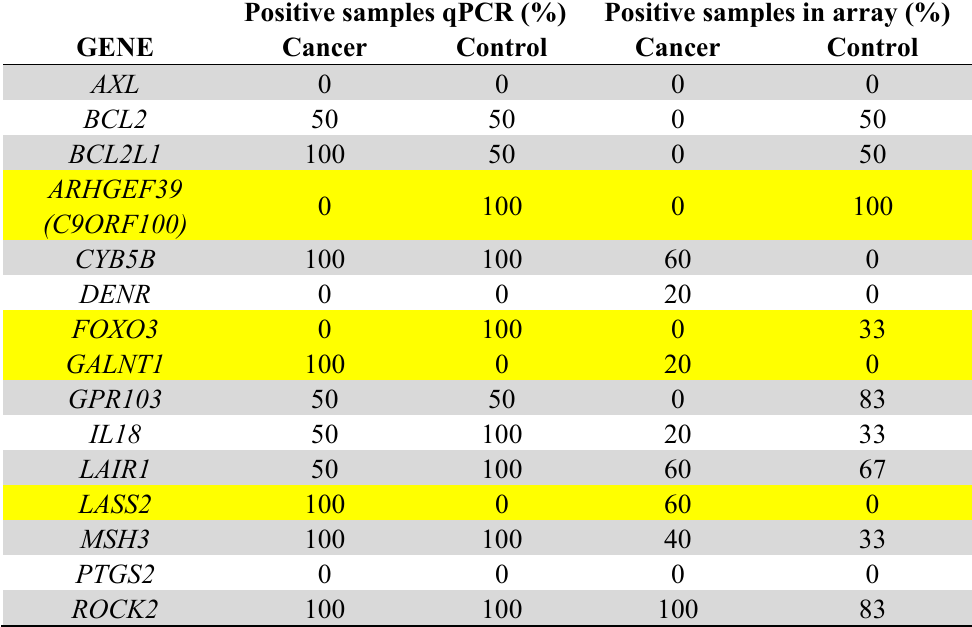
Table 2. Validation of the array. For PCR, each gene was tested in 2 samples for each group, while the number of samples characterized by array was 5 and 6 for cancer and control group, respectively. The four highlighted genes were selected as possible candidates for diagnostic of bladder cancer.